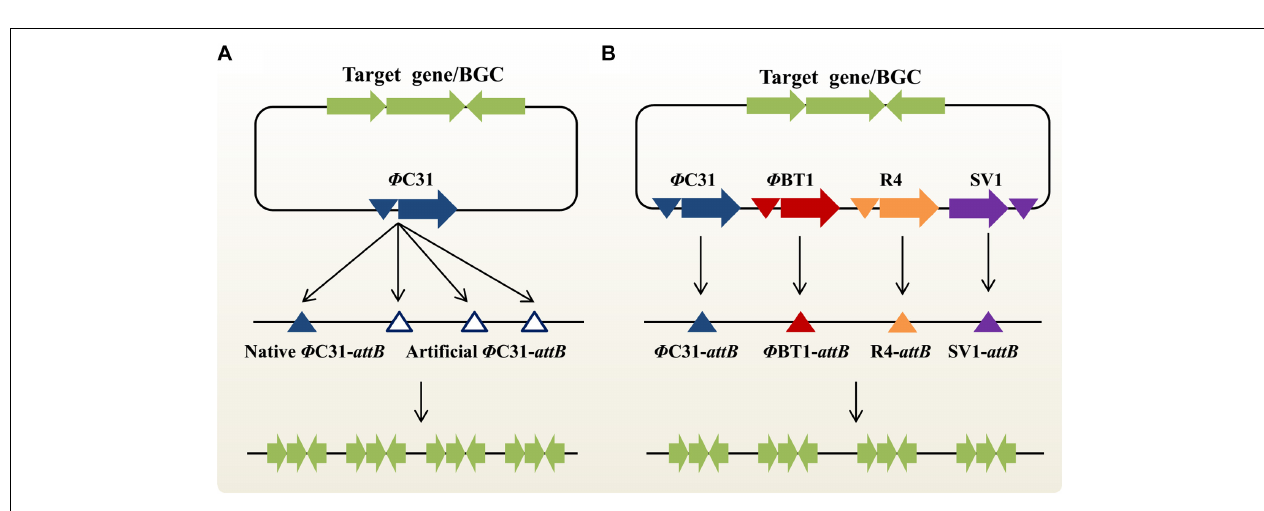
FIGURE 2 | Two emerging synthetic biology approaches for multi-copy integration of target genes or natural products BGCs in actinobacteria. (A) Multiplex site-specific genome engineering (MSGE) for discrete amplification of target genes or BGCs. This method is based on the “one integrase-multiple attB sites” concept. The blue and blank triangles represent the native and artificial (cid:56) C31 attB sites, respectively. (B) Advanced multiplex site-specific genome engineering (aMSGE) for multi-locus chromosomal integration of target genes or BGCs. This method is based on the “multiple integrases-multiple attB sites” concept. Particularly, these discrete attB sites are naturally occurring in the actinomycetal genomes. BGC, biosynthetic gene